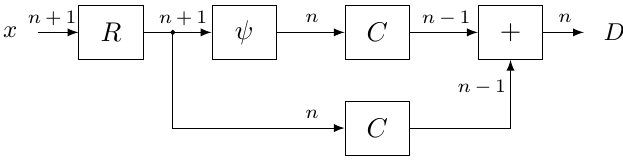
Figure 3: The sequence of gadgets in our new Boolean to arithmetic conversion